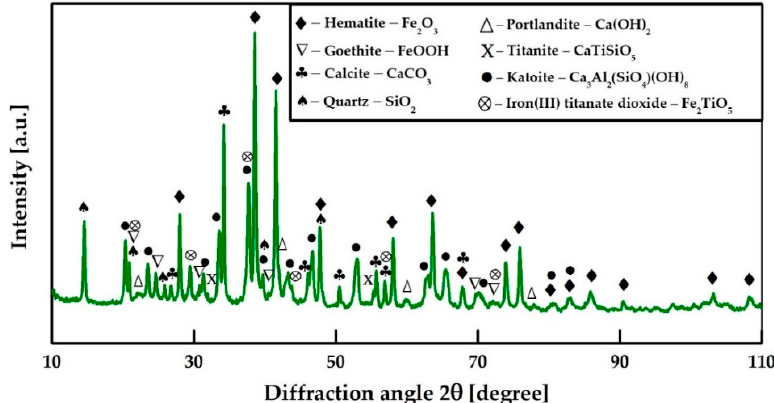
Figure 3. XRD analysis of the neutralized RM from Ural Aluminum Plant (Kamensk-Uralsky, Sverdlovsk region, Russia).